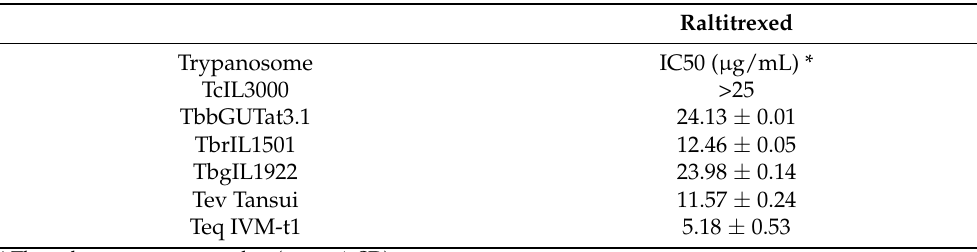
Table 2. The IC50 of raltitrexed against six Trypanosoma species, TcIL3000, TbbGUTat3.1, TbrIL1501, TbgIL1922, Tev Tansui and Teq